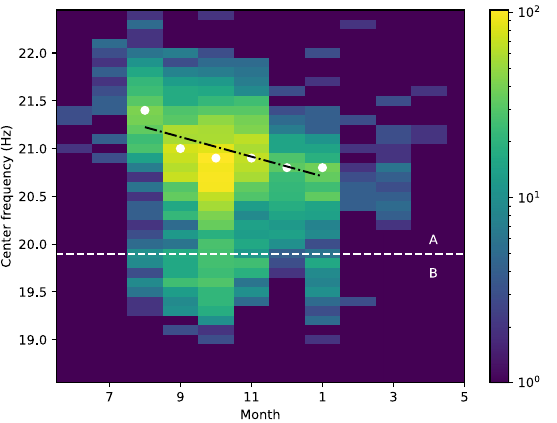
Figure 8. Bi-histogram of the center frequencies against months of the year. The horizontal line shows the separation between type A and type B pulses. The fitted linear model is shown as a black dashed line.